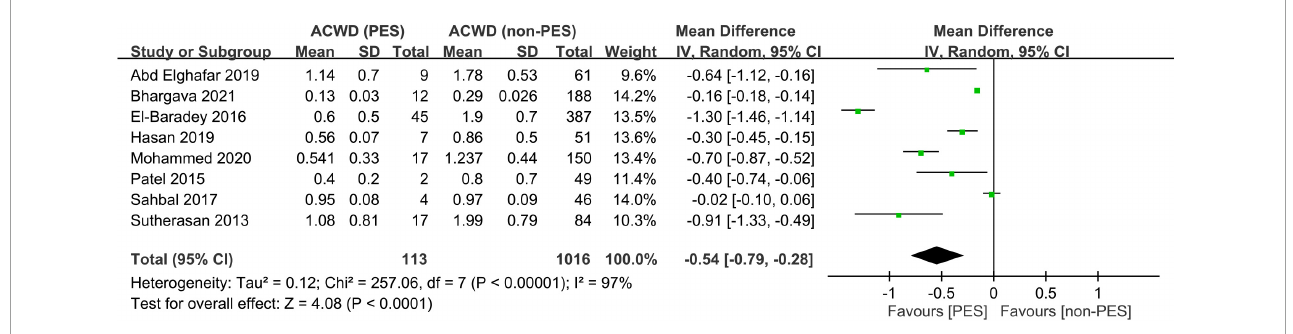
in intubation duration, size of tracheal tube, patient gender, and the operator’s experience.